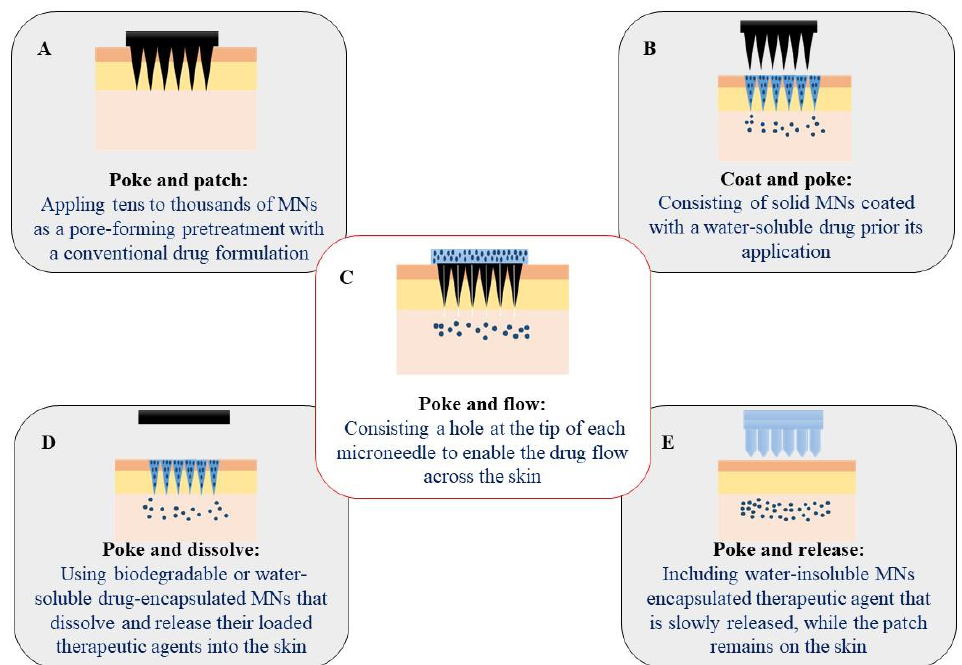
Figure 2. A schematic representation of delivery approaches using various types of microneedle arrays (MNs): ( A ) poke-and-patch (solid MNs), ( B ) coat-and-poke (coated MNs), ( C ) poke-and-flow (hollow MNs), ( D ) poke-and-dissolve (dissolvable MNs), and ( E ) poke-and-release (hydrogel forming MNs).